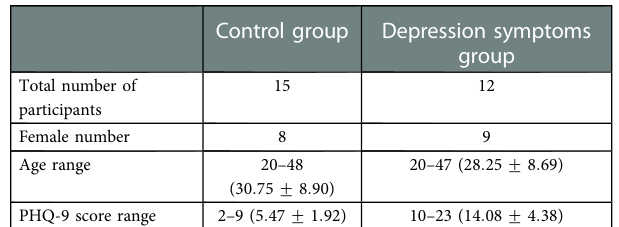
TABLE 2 Participants ’ traits.